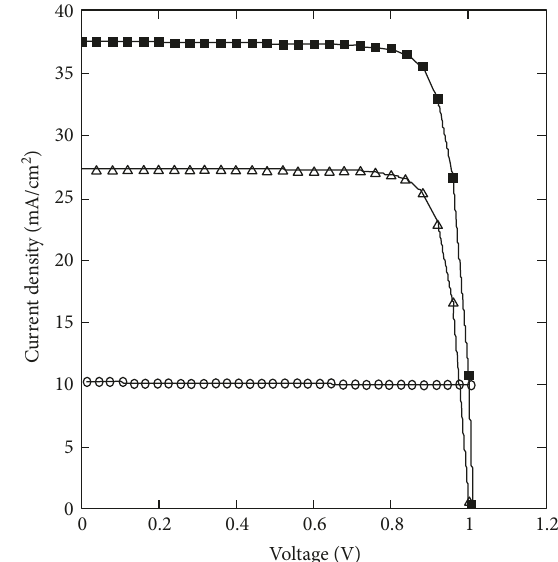
Figure 3: Current density versus voltage for the two subcells in tandem and tandem cell, for the thicknesses 0.64 μ m and 60.62 μ m of the Cu O layer and the c-Si layer, respectively: J 2 ( Δ ), and J ( ■ tandem